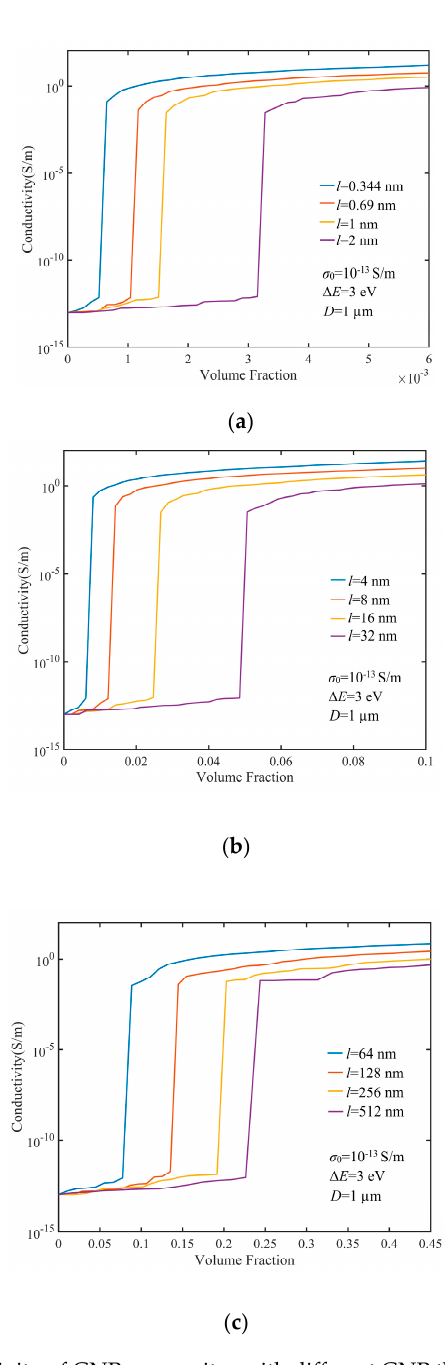
11 of 17 Figure 6. Tunneling effects of different barrier heights on the conductivity of GNP composites. The influence of polymer conductivity on the conductivity of GNP composites is illustrated in Figure 7. We took σ 0 = 10 − 15 –10 − 9 S/m. It could be seen that the matrix conductivity only changed the part of conductivity below the percolation threshold. For instance, D = 1000 nm, l = 10 nm, Δ E = 3 eV, 13 1 i d = d vdW , and σ 0 = 10 − 9 S/m; on the basis of Equation (11), 13 1 i G = 1.74 × 10 − 6 S. The direct conductance was L x L y σ 0 / d = 5.8 × 10 − 10 S for L x = L y = 10 μ m, which was much less than contact conductance. As a result, once the conductive network was established, the current of the GNP composites was determined by the tunneling current, and the conductivity was determined by contact conductance. The percolation threshold was closely associated with the formation of the conductive network in the composite without being influenced by the conductivity of the polymer. Figure 7. Electrical conductivity of GNP composites of different polymer conductivities. In order to analyze the impact of aspect ratio of the filler GNP on the percolation threshold, the conductivities of composites with different thicknesses of GNPs were calculated, as shown in Figure 8a–c. Thickness changed in the range of 0.344–256 nm. The results suggested that the percolation threshold increased as l increased. If l < D , the number of GNPs needed to form percolation paths did